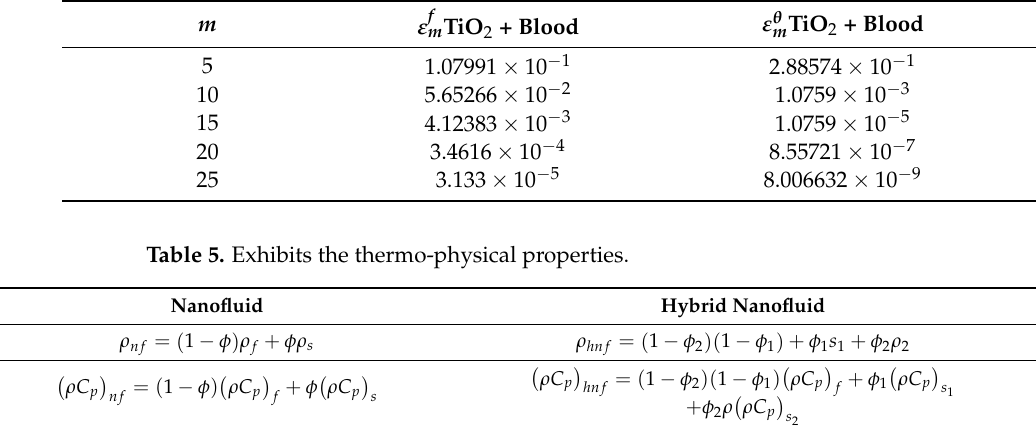
Table 4. Convergence of the method for TiO 2 + Blood when Pr = 6, M = 10, Ec = 1, k ∗ = 1, λ = 1.